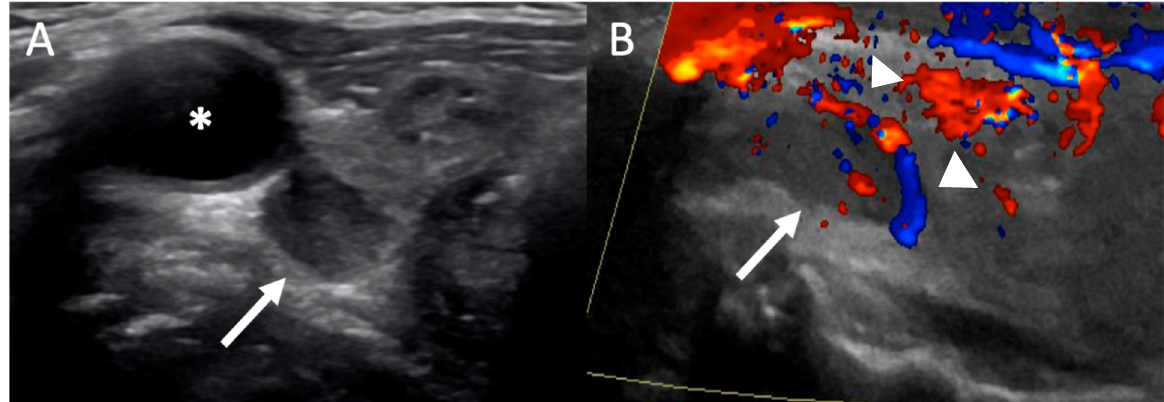
Figure 2. Ultrasound: 54-year-old woman with primary hyperparathyroidism (PHPT). Transverse grayscale ( A ) ultrasound image demonstrates an ovoid hypoechoic lesion (white arrow) posterior to the right lobe of the thyroid gland and carotid artery (*) consistent with a parathyroid adenoma. ( B ) Color doppler ultrasound image shows a polar feeding vessel with peripheral vascularity (white arrowheads).